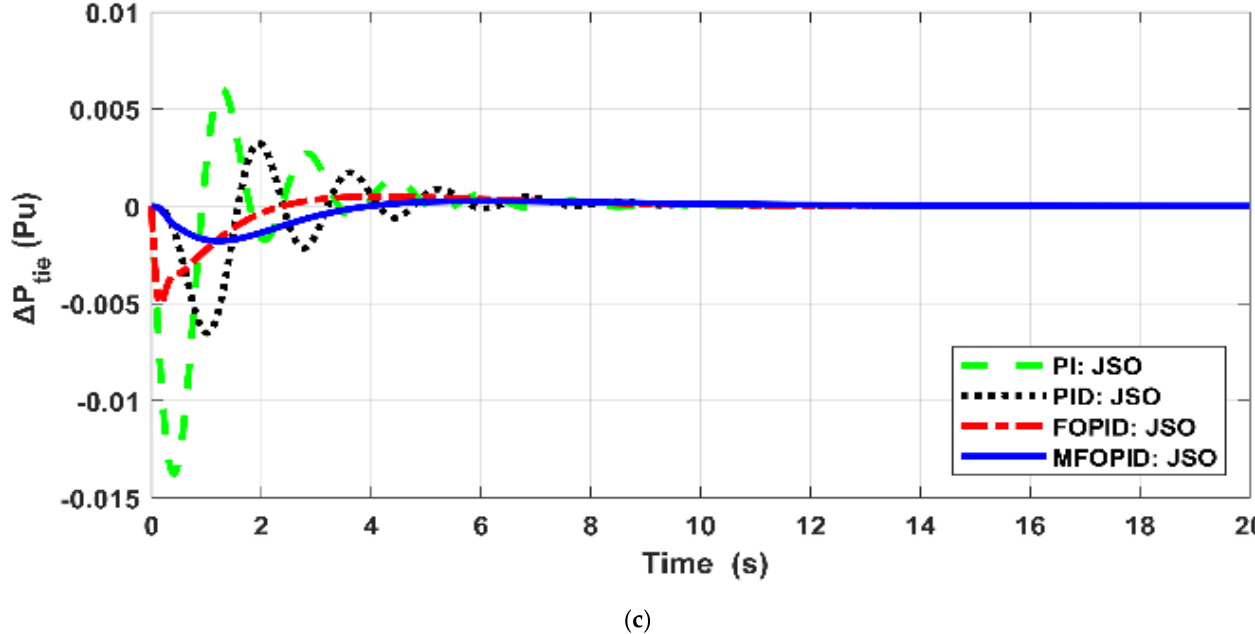
Figure 10. Output response of the PS considering case − 2 for ( a ) ∆ F 1 ; ( b ) ∆ F 2 ; ( c ) ∆ P ite . Table 3. Numerical results for hybrid power system considering